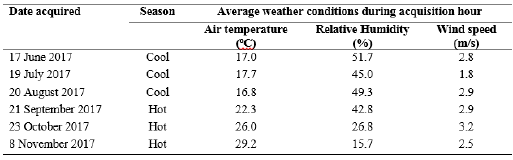
Table 2: Cloud-free Landsat 8 imageries used for